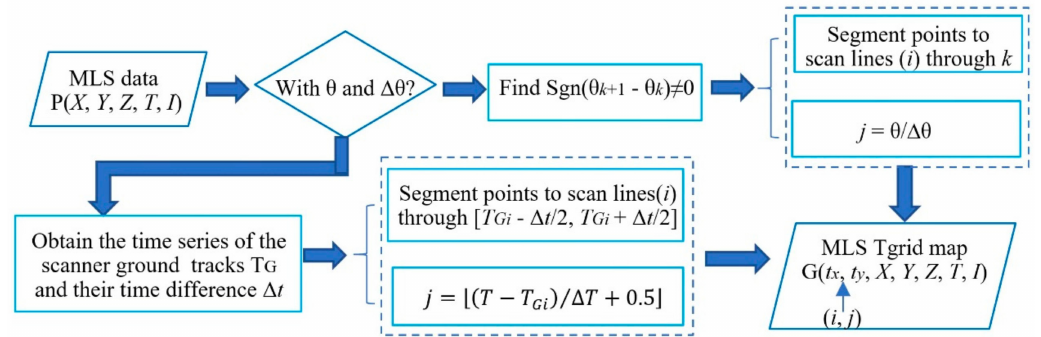
Figure 3. The flow chart of construction of a Tgrid for MLS